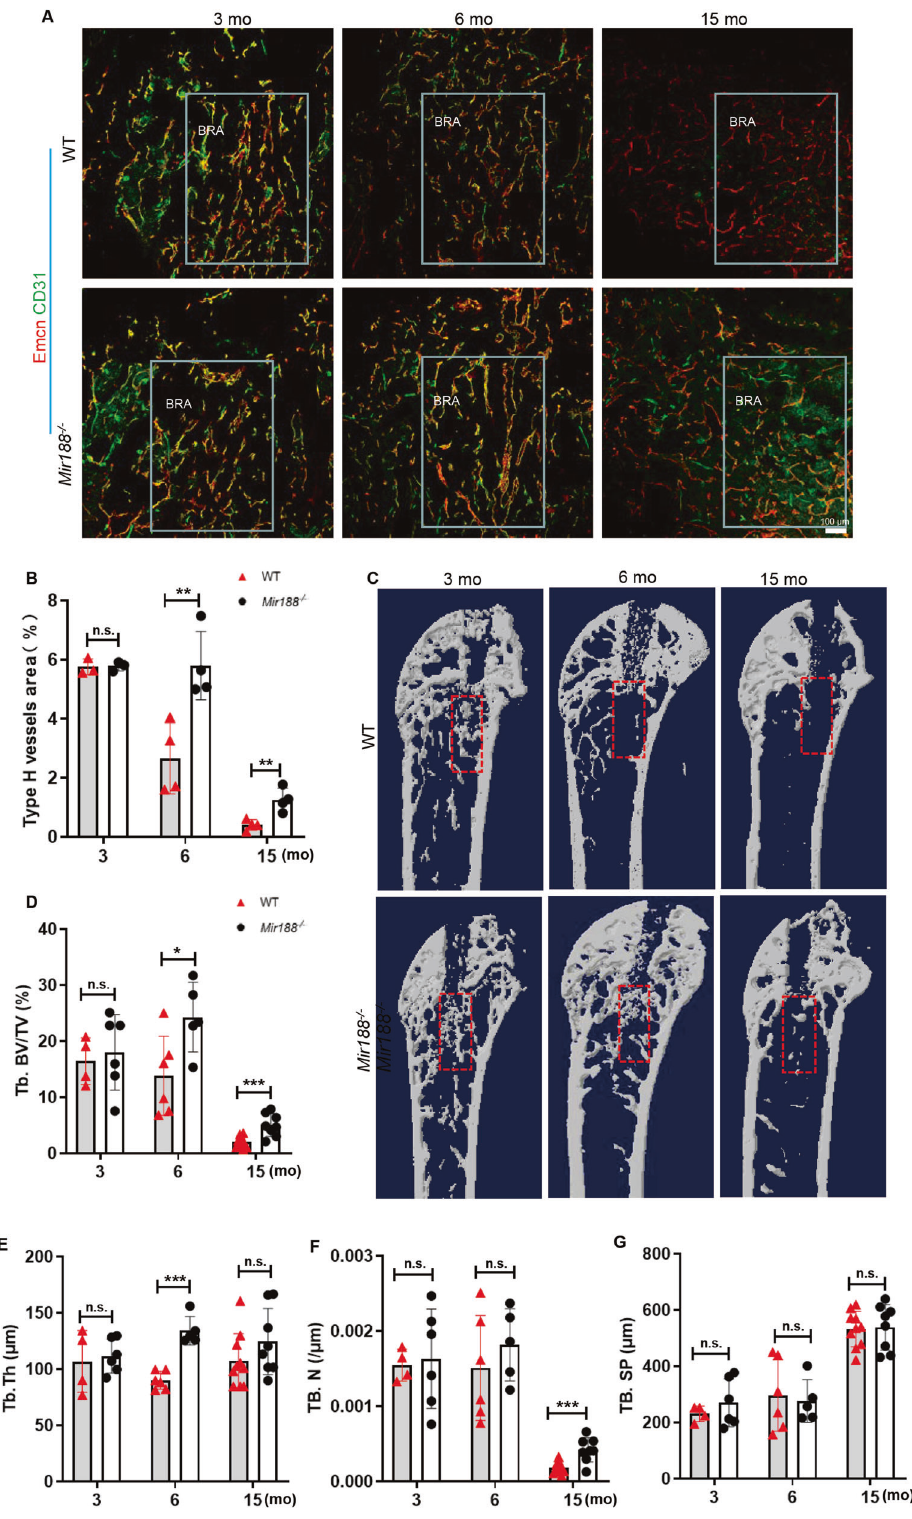
Fig. 5 Mice with knockout miR-188 showed more type H vessels and accelerated bone regeneration during bone damage repair. A Representative images of Emcn (red) and CD31 (green) immunostaining of the bone regeneration area in femur sections from the indicated mice. Scale bar = 100 μ m. B Quantitative analysis of type H vessels in the bone regeneration area of femora from the indicated mice. n = 3 (3-month-old WT or miR188 − / − mice), n = 4 (6-month-old and 15-month-old WTor miR188 − / − mice). C Representative μ CT images of trabecular bone microarchitecture in the bone regeneration area from 3-month-, 6-month-, and 15-month-old WT or miR188 − / − mice 0 days and 7 days after surgery. D – G Quantitative analysis of trabecular bone microarchitecture in the bone generation area from the indicated mice. n = 4 (3-month WT mice), n = 6 (3-month miR188 − / − mice and 6-month WT mice), n = 5 (6-month miR188 − / − mice), n = 10 (15-month WT mice), n = 8 (15-month miR188 − / − mice). BRA: bone regeneration; mo: month. Data are shown as the mean ±SD. n.s. no signi fi cance; * P <0.05; ** P <0.01; *** P <0.001 by two-tailed Student ’ s t test. Cell Death and Disease (2022)